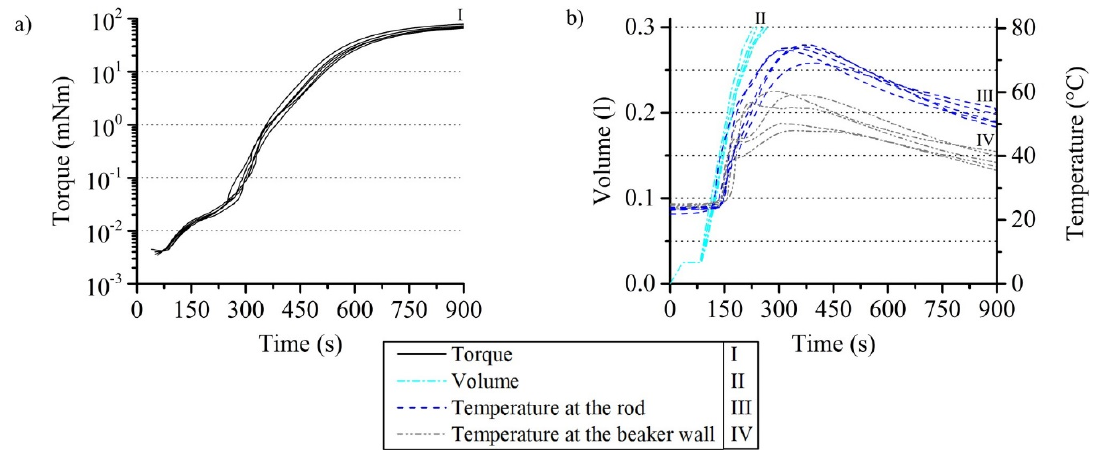
Figure 6. Reproducibility ( a ) of the shear stress within reacting PUR foam and ( b ) the volume expansion as well as the temperature development.